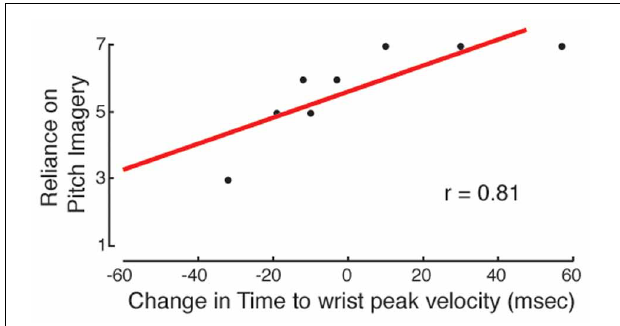
FIGURE 7 | Auditory imagery and movement anticipation. In the MP group, the development of movement anticipation from MP0 to MP1 (measured as the difference in time to wrist peak velocity) is related to the use of auditory imagery (pitch imagery). The more the subjects reported having used auditory imagery, the more they showed anticipation of wrist peak